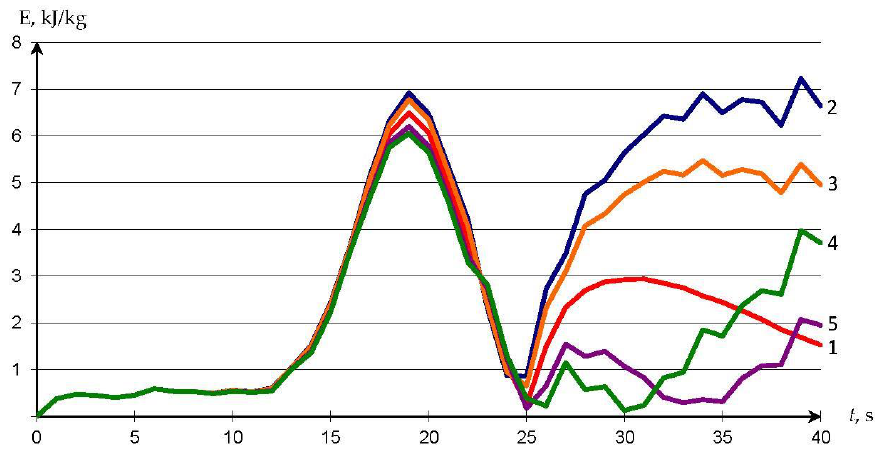
Figure 5. Response error E ( t ) of quadratic integral models.